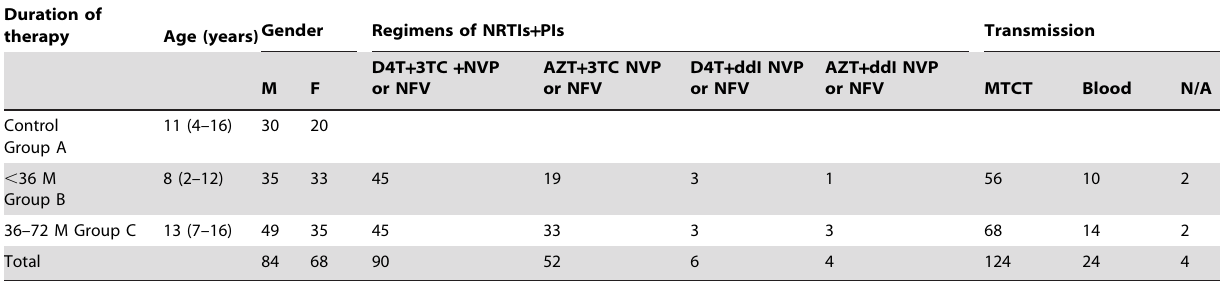
Table 2. Patient information.